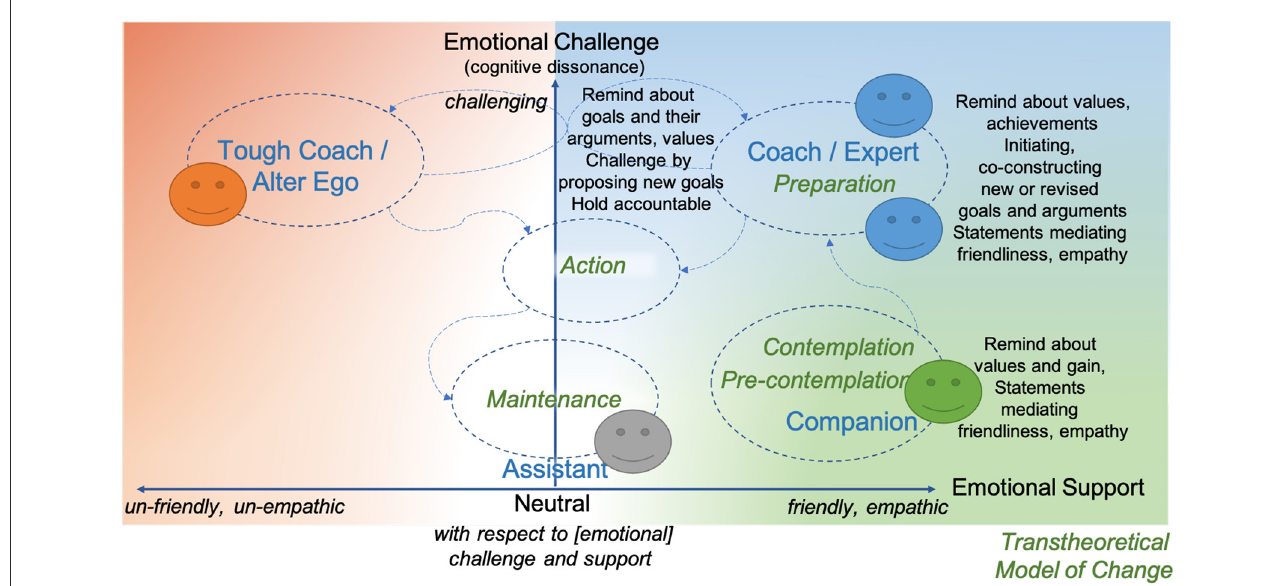
FIGURE3 A total of five characters interpreted in the framework for mapping behaviors of a digital agent, Uno is colored green, Dos is gray, Tres and Cuatro are blue, and Cinco is orange. The arrows represent desirable transitions between TTM stages ending in a stable state of maintenance, there are also potential transitions between roles with a switch to the tough coach and back. The color scheme of the agents follows the colors of the compassion-focused therapy as in Figure 1, with the complementary color gray for the neutral assistant.